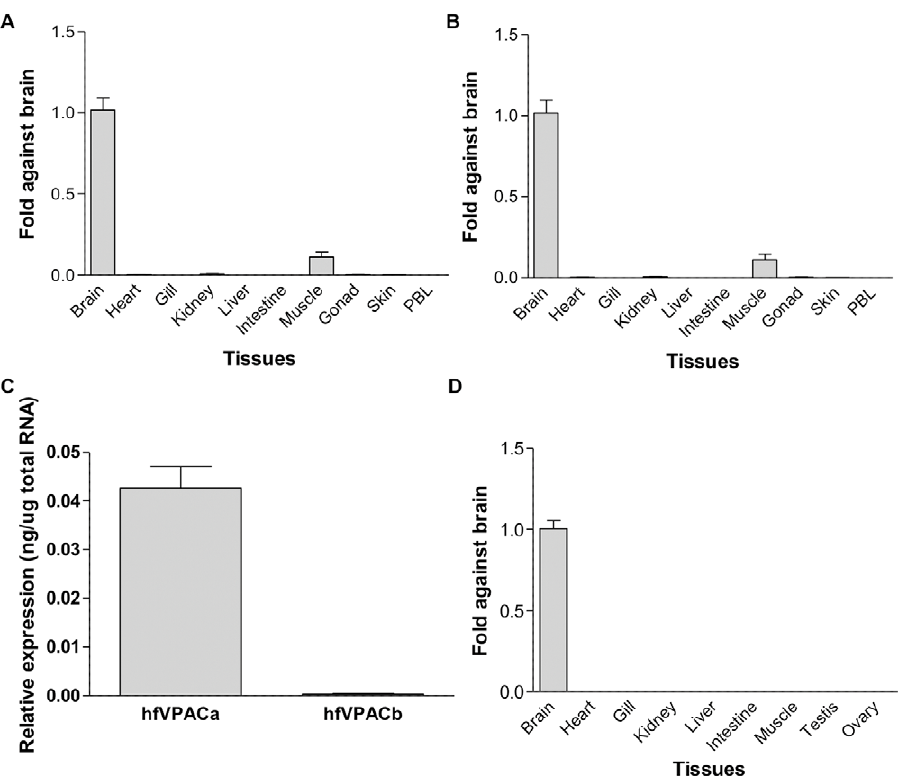
Figure 5. Transcript expression profile of agnathan VPAC receptors and PACAP. Tissue distribution patterns of (A) hfVPACa and (B) hfVPACb; a relative abundance of 1 was set arbitrarily for the mRNA expressed in the brain. (C) The expression level of hfVPAC receptors in the hagfish brain was calculated from respective standard curves. (D) Tissue distribution pattern of jlpPACAP; a relative abundance of 1 was set arbitrarily for the mRNA expressed in the brain. Data are expressed as the mean 6 S.E.M. of four experiments performed in duplicates.